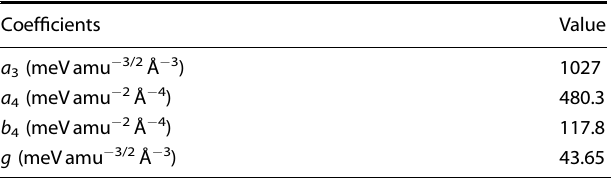
potential for A g (25) mode with amplitudes ranging from − 2.2 to